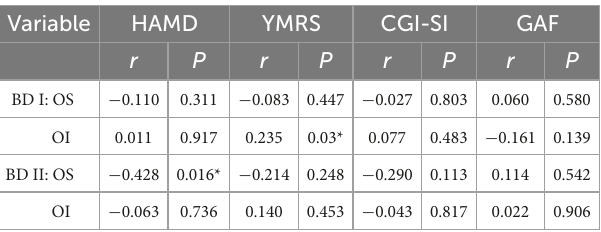
TABLE 4 Correlation between OS or OI and clinical characteristics in BD I and BD II patients ( α = 0.05). Variable HAMD YMRS CGI-SI GAF